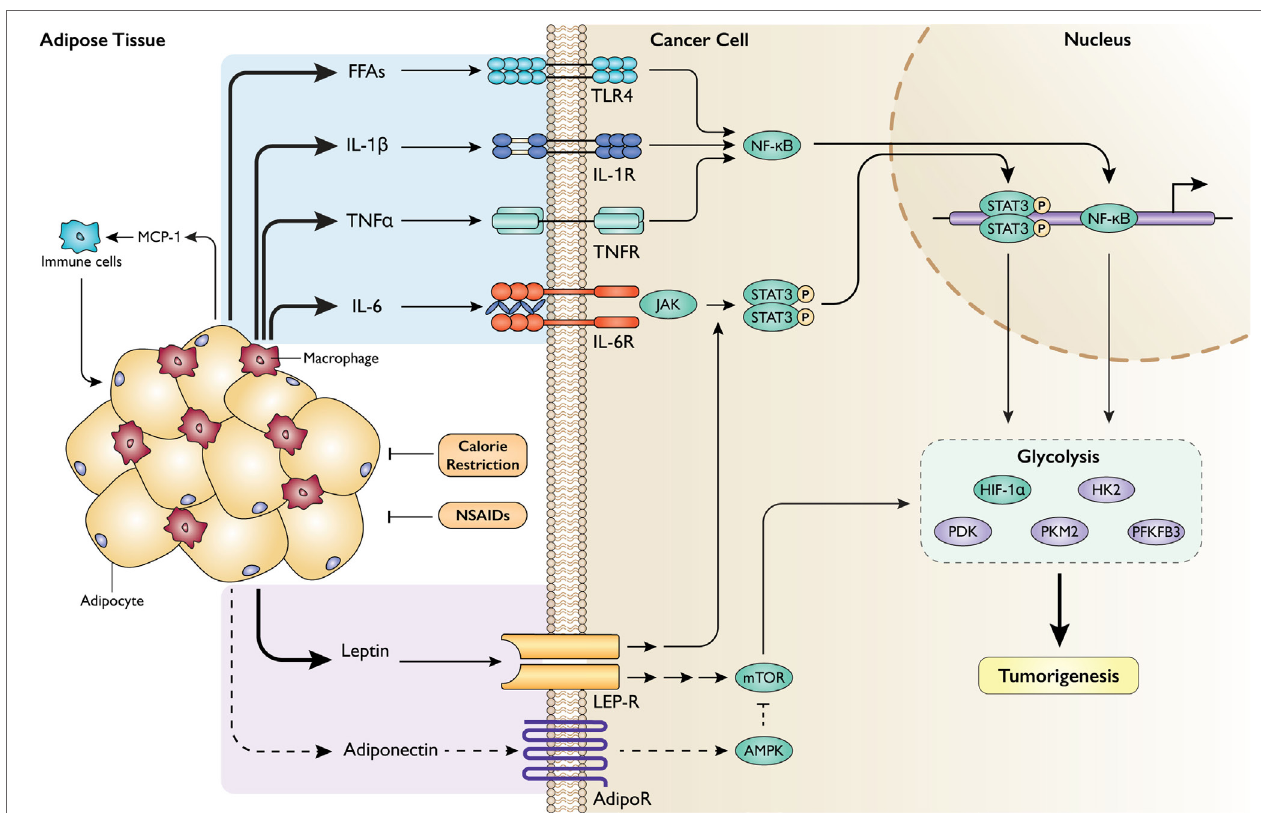
FiGURe 2 | Impact of obesity-associated adipose tissue dysfunction and inflammation on cancer cell metabolism. Adipose tissue in the obese state becomes the site of profound inflammatory activity, recruiting immune cells that secrete a barrage of cytokines that can act on neighboring cancer cells to promote tumorigenesis through metabolic levers. MCP-1, monocyte chemoattractant protein-1; FFAs, free fatty acids; IL-1 β , interleukin-1 beta; TNF α , tumor necrosis factor alpha; IL-6, interleukin-6; TLR4, toll-like receptor 4; (IL-1/TNF/IL-6)R, receptor; NF- κ B, nuclear factor-kappa B; JAK, Janus kinase; STAT3, signal transducer and activator of transcription 3. Obesity also disrupts the endocrine functions of adipose tissue. LEP-R, leptin receptor; AdipoR, adiponectin receptor; NSAIDs, non-steroidal anti-inflammatory drugs. Intervention approaches are shown in